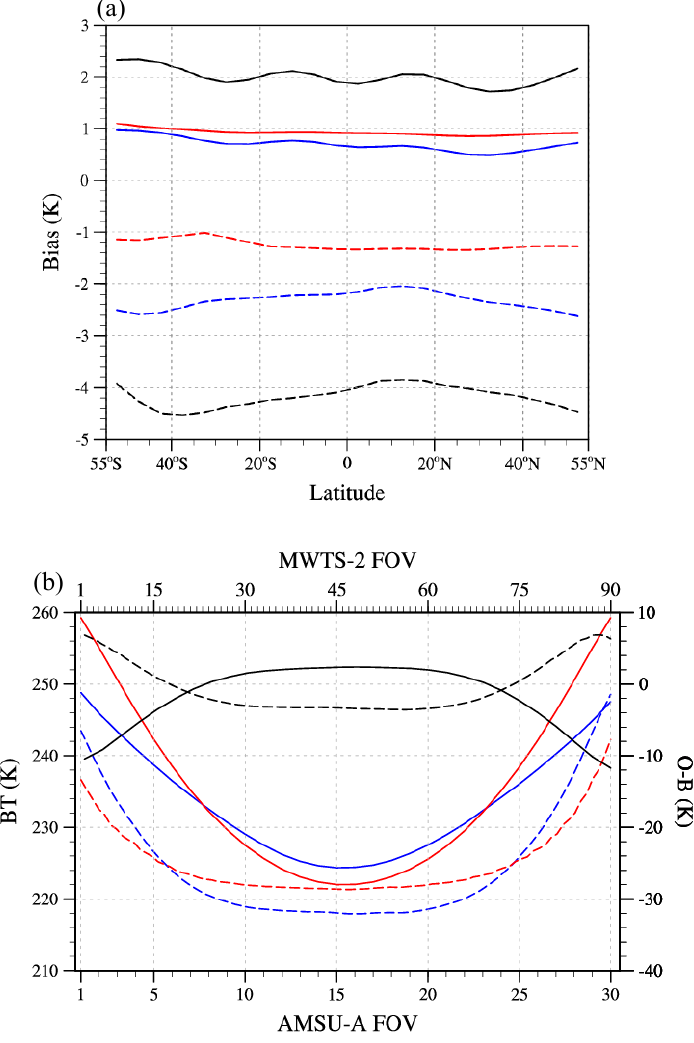
Figure 6. ( a ) Latitudinal dependencies of clear-sky O-B biases for AMSU-A channels 3 (black solid), 4 (blue solid), and 5 (red solid) and MWTS-2 channels 1 (black dashed), 2 (blue dashed), and 3 (red dashed). ( b ) Scan dependencies of clear-sky mean observed (blue) and CRTM-simulated (red, left ordinate) brightness temperatures and O-B biases (black, right ordinate) for AMSU-A channel 3 (solid curve) and collocated MWTS-2 channel 1 (dashed curve) data points using data over oceans from 1 July to 14 July 2014.